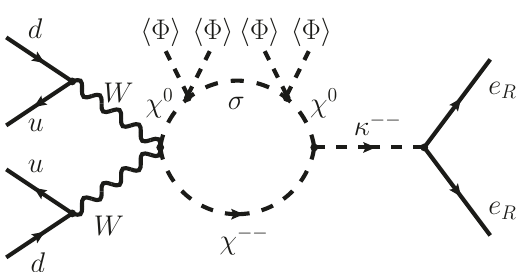
Figure 1 . One-loop diagram, in the mass insertion approach, contributing to neutrinoless double beta